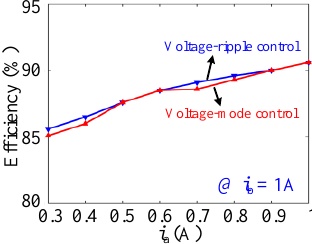
Figure 14. Measured efficiency of the conventional voltage mode-controlled converter and the proposed voltage ripple-controlled PCCM SIDO buck converter against i a when i b = 1 A.